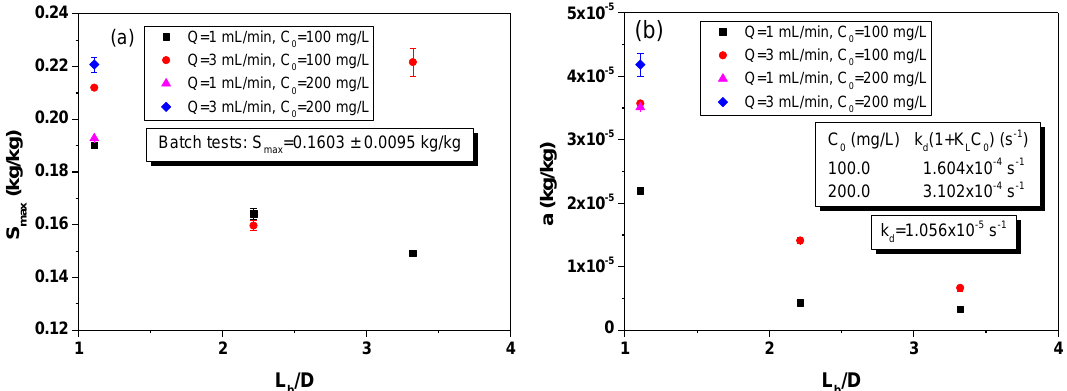
Figure 6. Estimated sorption properties of BP bed as functions of all pertinent parameters: ( a ) maximum sorption capacity; ( b ) sorption kinetic constant.